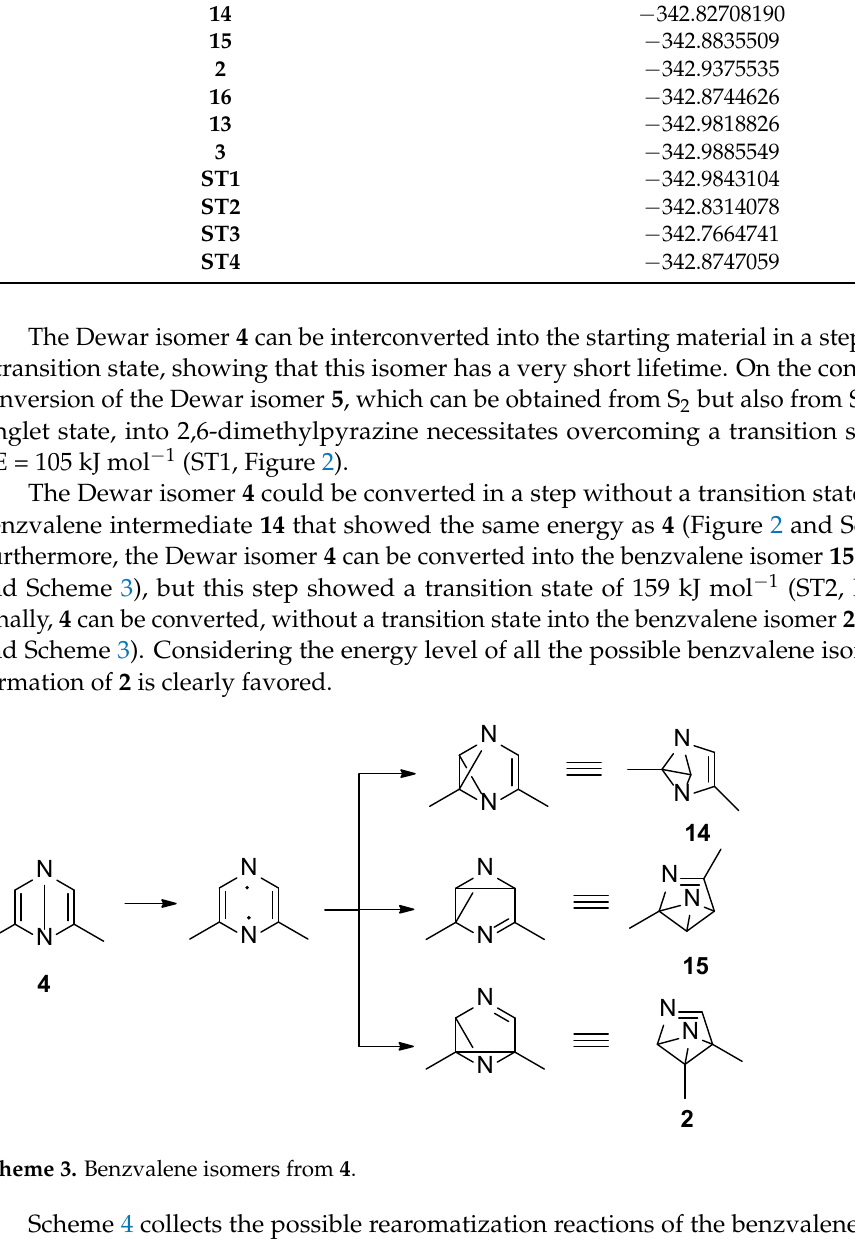
Table 1. Total energy of the optimized structures.